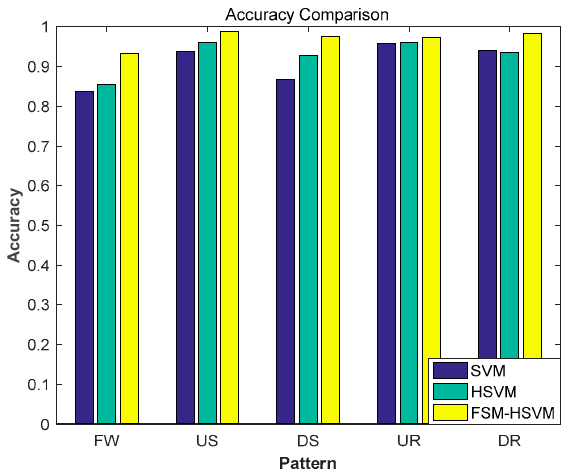
Figure 6. Comparison of recognition rates of three algorithms. Table 6. DRs of locomotion mode